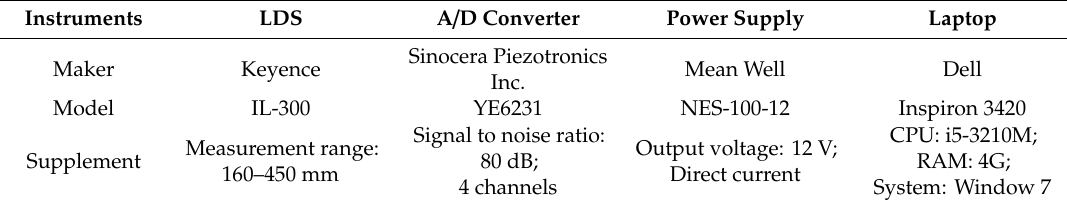
Table 1. The instruments of the LDS measurement system.